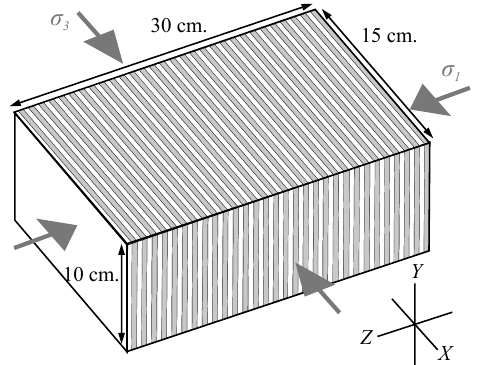
Figure 2. Sketch of a multilayer experiment. The arrows indicate the direction of the principal stresses applied by the deformation apparatus. The initial layer thickness was ∼ 4–5mm. After Gomez- Rivas and Griera